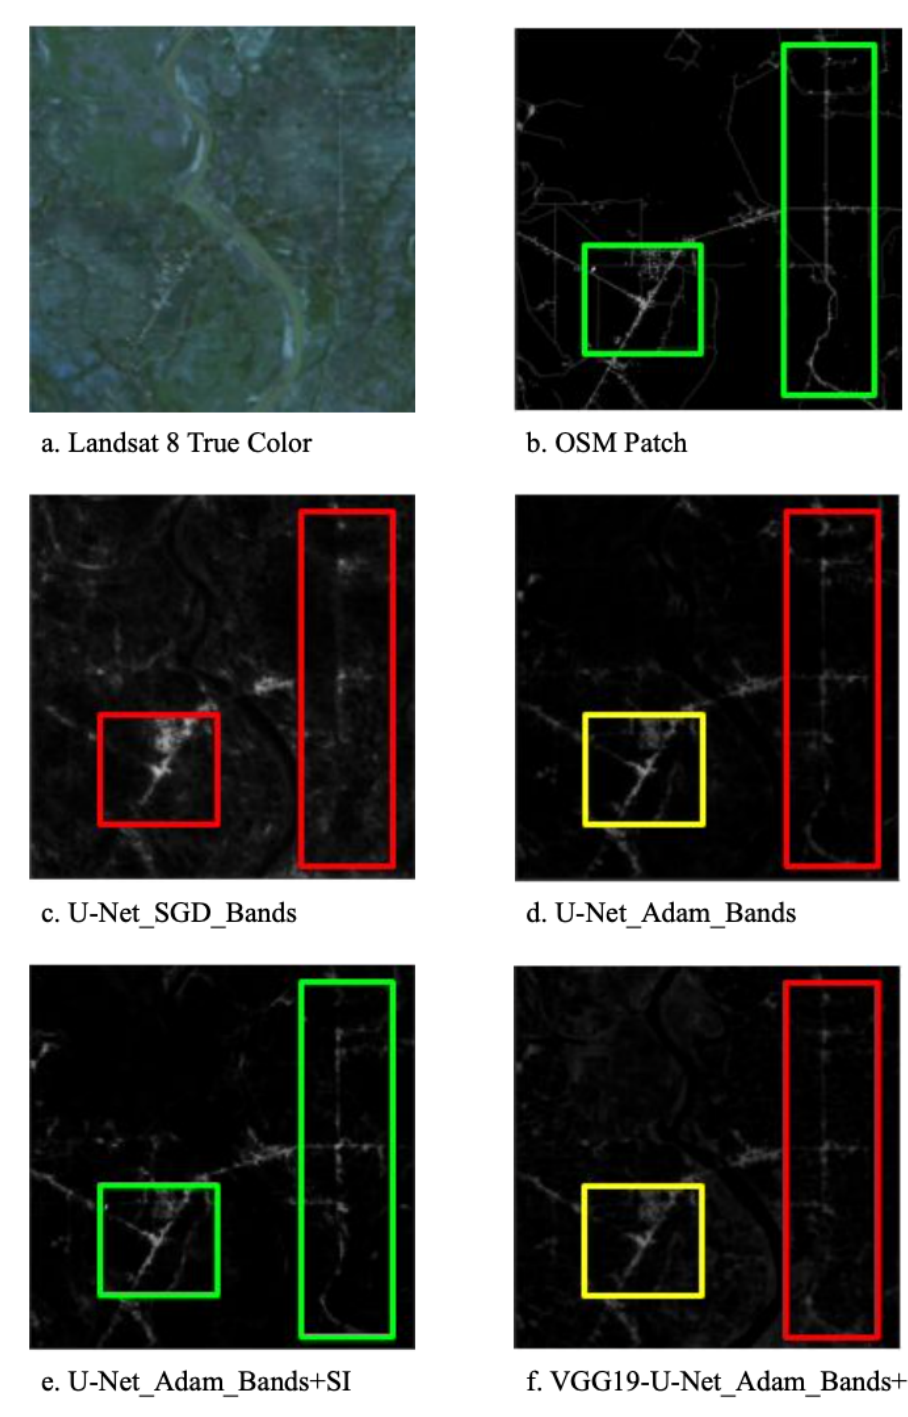
Figure 10. Impervious surface predictions from the four deep learning models on an image repre- senting a rural